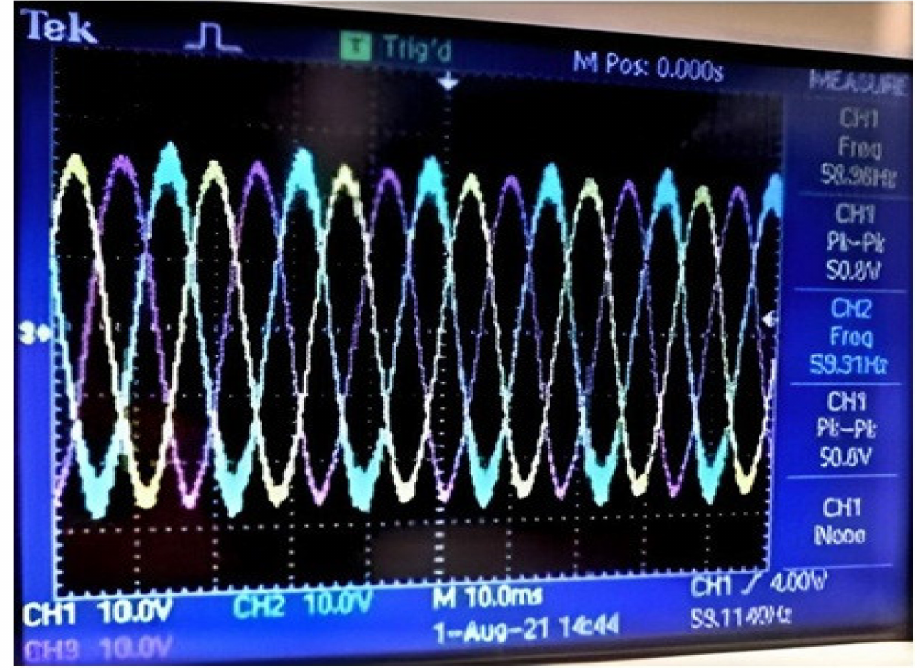
Figure 24. The three-phase voltage output by the inverter in the experiment.